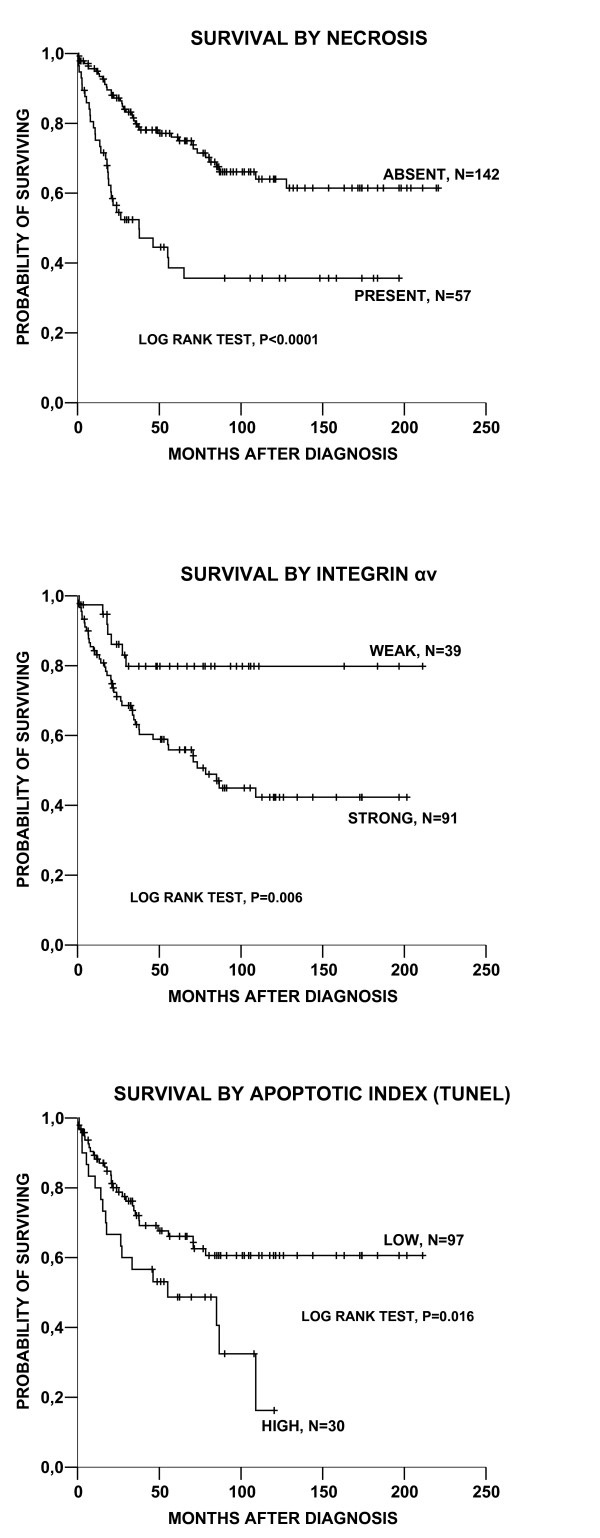
Survival curves according to the Kaplan-Meier method by (A) absence or presence of necrosis, (B) expression of integrin αv, and (C) apoptotic index (AI) in nodular melanoma with death of the disease as end-point.